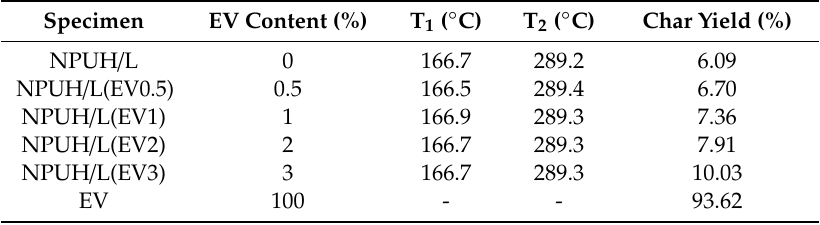
Figure 7. ( a ) Mass loss curves of the reference foam with di ff erent EV contents; ( b ) First derivative (DTG) curves of the reference foam with di ff erent EV contents; ( c ) Heat release curves of the reference foam with di ff erent EV contents. Table 2. Specifications of composites.